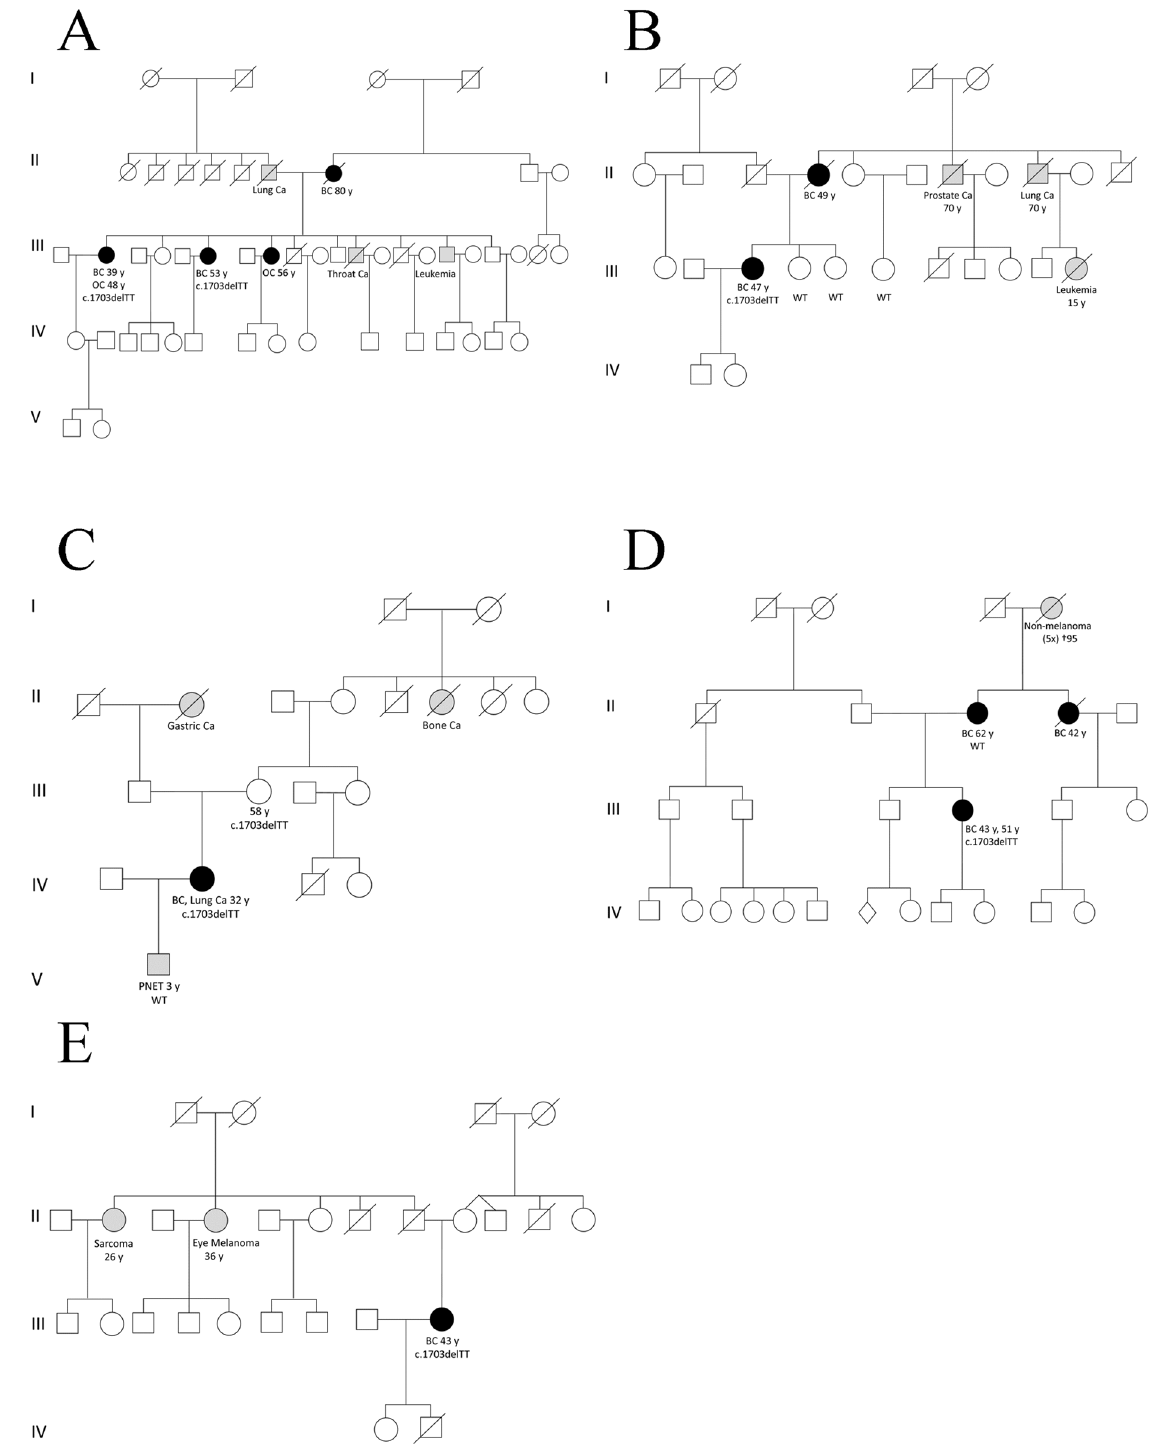
Fig 3. ERCC2 frameshift mutation c.1703_1704delTT (p.Phe568fs) in familial breast and ovarian cancer pedigrees. Individuals with breast cancer (BC), ovarian cancer (OC) or both (BC, OC) are shown as circles filled in black. Individuals tested positive for the familial mutation are indicated in detail; those with WT (wild-type) have been tested negative. All affected individuals with BC or OC not tested for germline mutations in ERCC2 were either deceased or refused testing. (A) German, (B) Lithuanian and (C-E) Czech